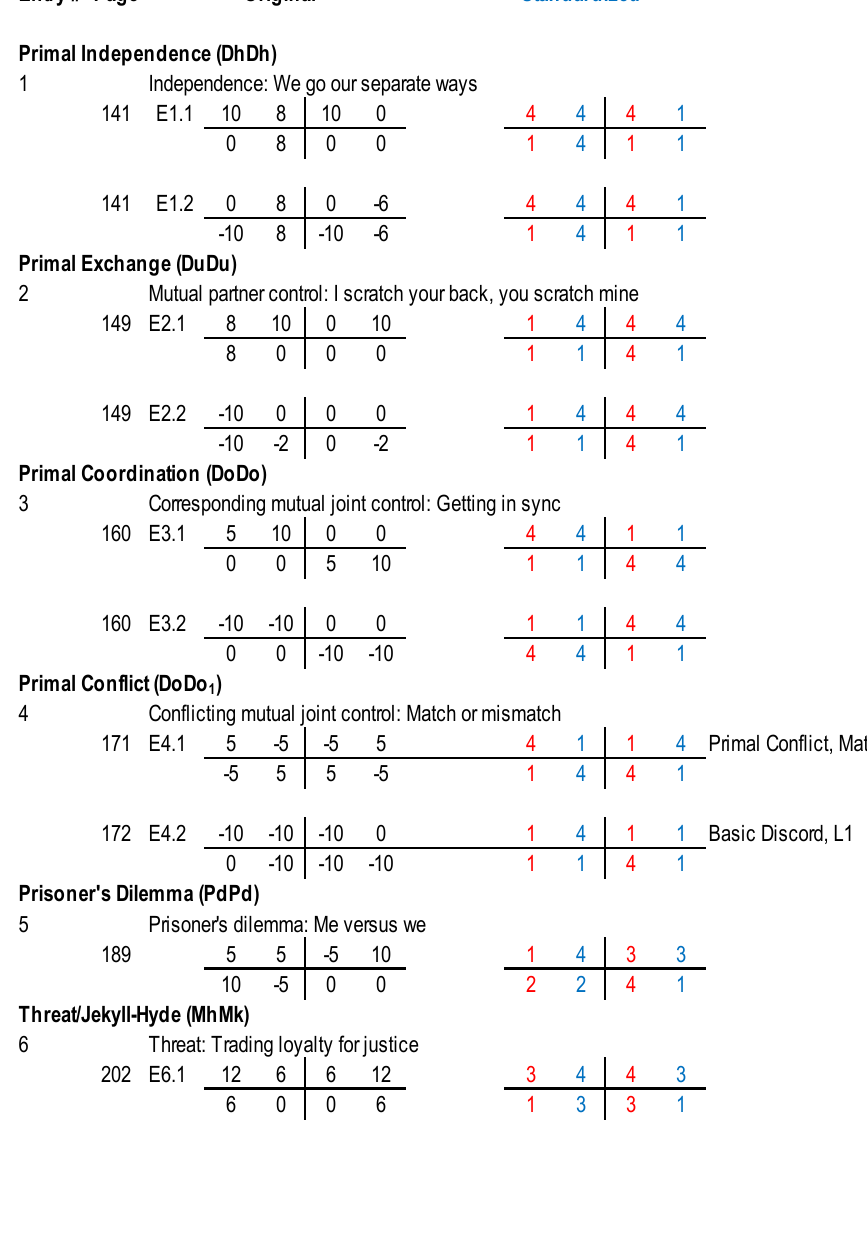
Figure A10. Illustrative payoff matrices for entries in the Atlas of Interpersonal Situations and ordinal equivalents in standardized orientation (Row’s 4 right, Column’s 4